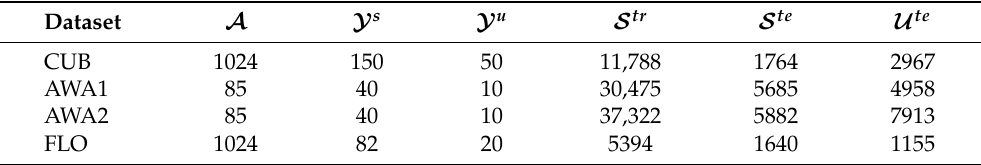
Table 1. Statistics of five benchmark datasets. From left to right, the columns show the dataset name, the class attribute dimensionality A , the number of seen classes Y s and unseen classes Y u , all training instances S tr , and testing seen instances S te and unseen instances U te